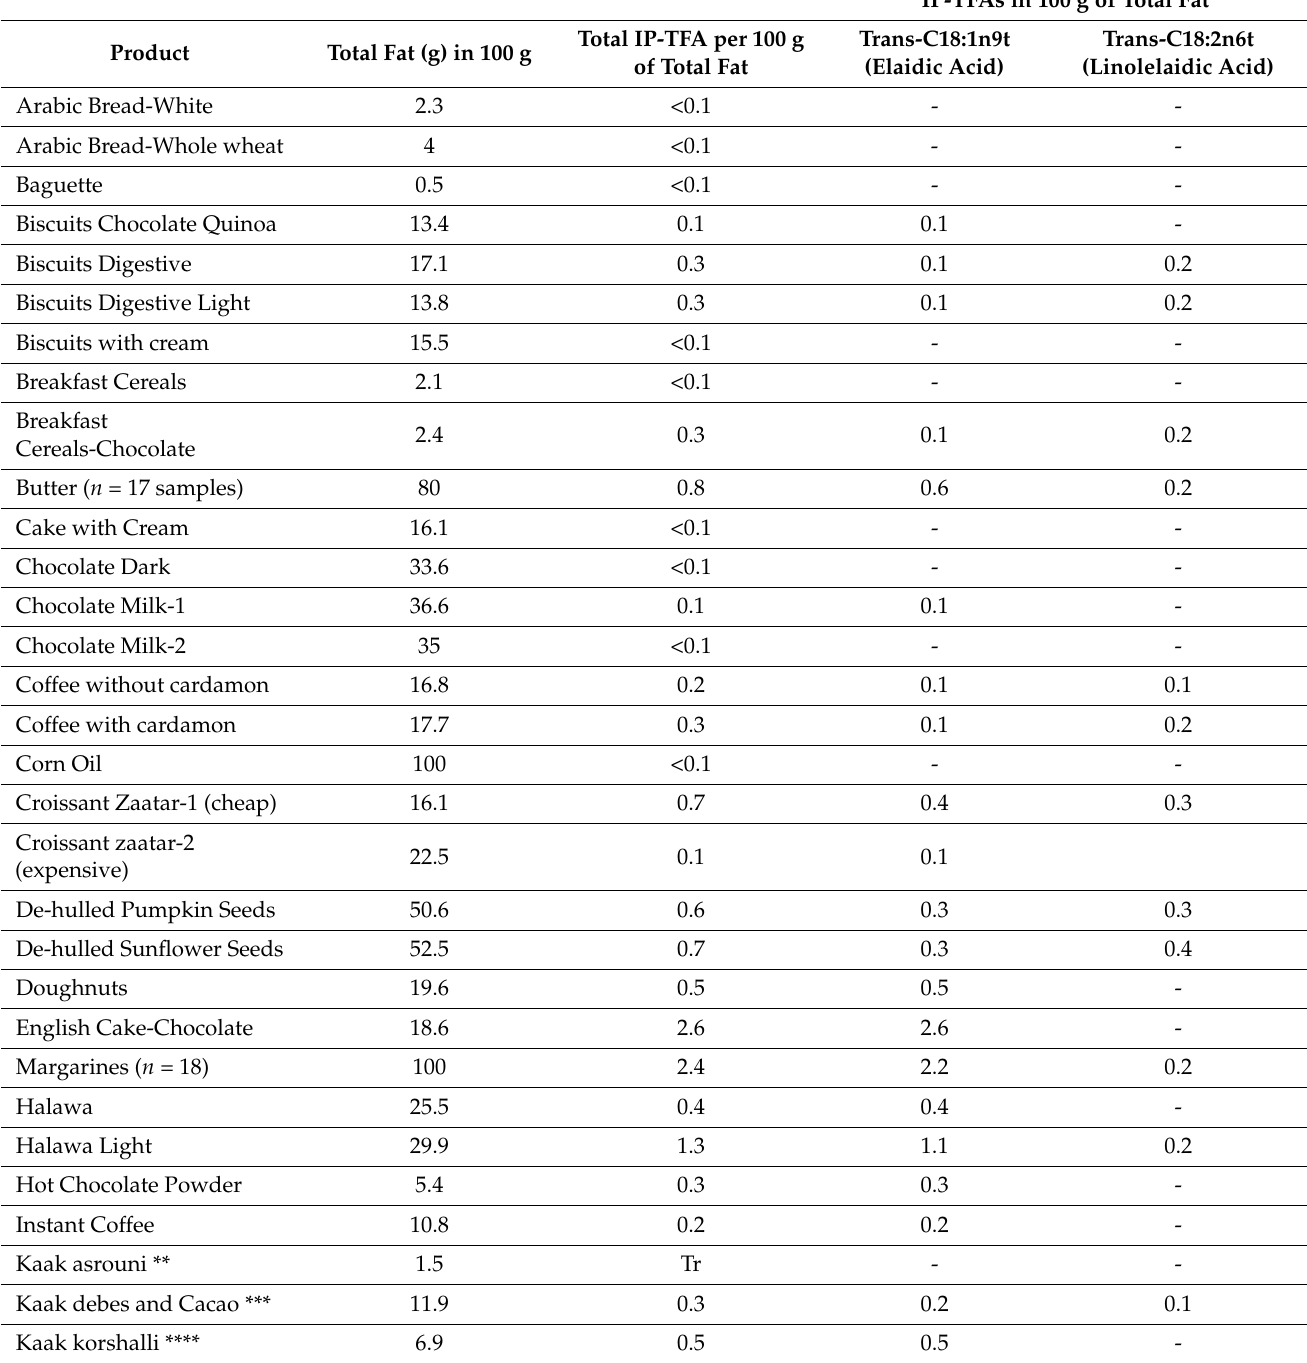
Table 3. Total fat in 100 g of edible portions, total IP-TFAs and IP-TFAS (EA and LEA) in 100 g of total fat of Market food products collected from Lebanese